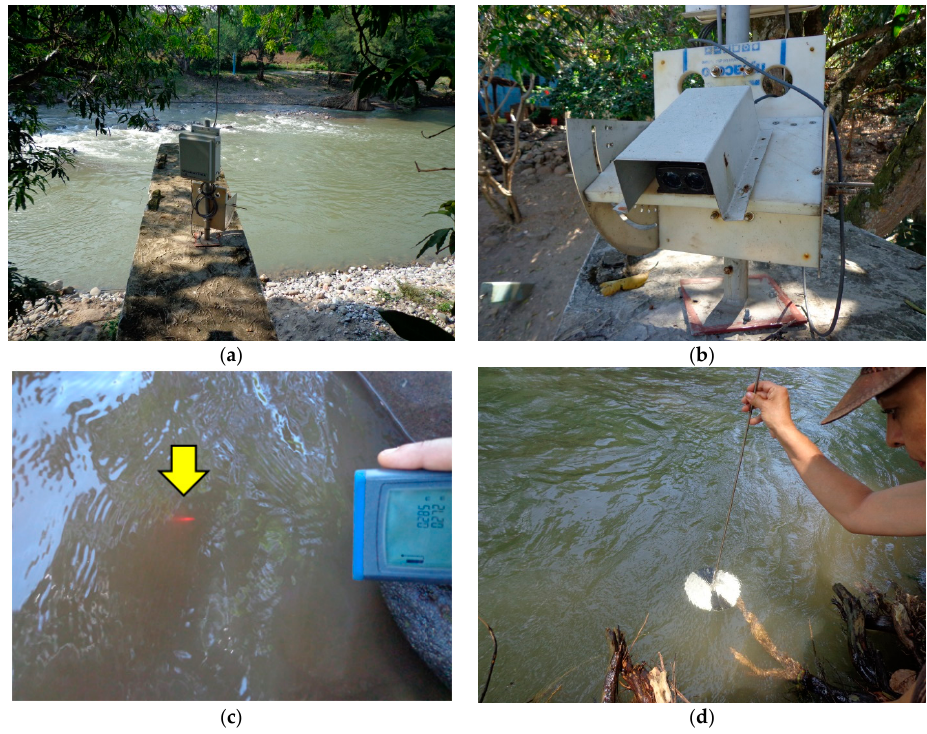
Figure 2. Experiment at the Amacuzac River (Mexico): ( a ) monitoring system with an inclined Lidar (looking northeast); ( b ) close-up of the inclined Lidar (with a sun shield to prevent overheating); ( c ) Tyndall effect (arrow) observed with a red laser beam (pointer of an inclined handheld laser rangefinder, which was taking erroneous distance data in this case); ( d ) Secchi disk used to assess water transparency.